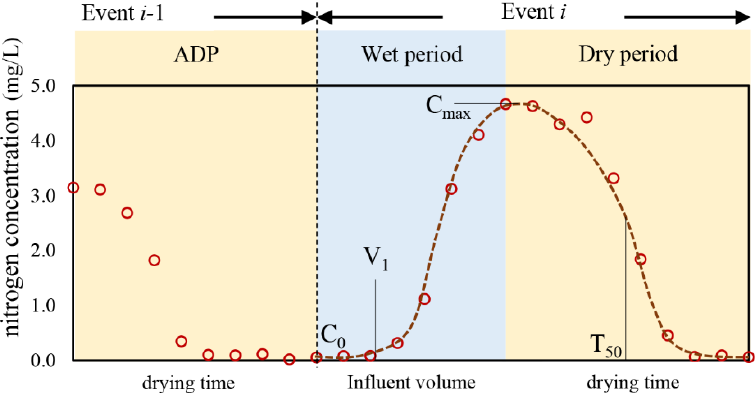
Figure 3. Diagram showing characteristic indicators for nitrogen concentration change during wet and dry periods (take NO 3 − as an example).